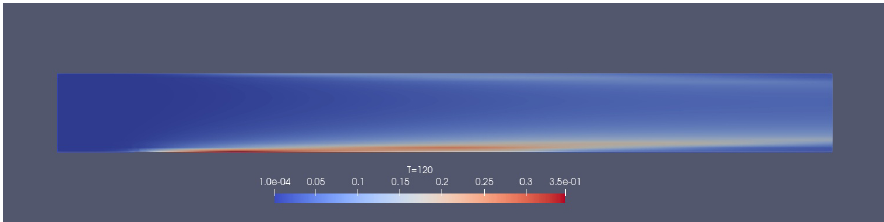
( a ) Intensity map of u g at t = 100.